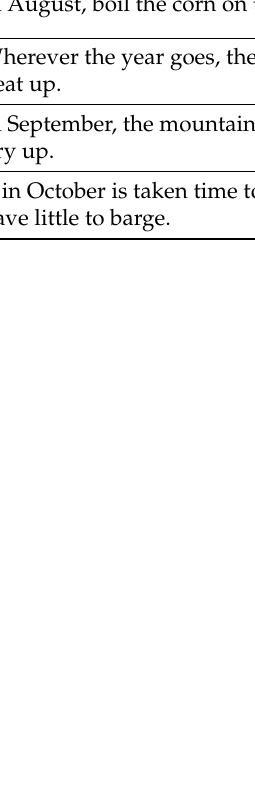
Table 4. Prayers uttered to calm the thunderstorm, dedicated to Santa B á rbara, and another to